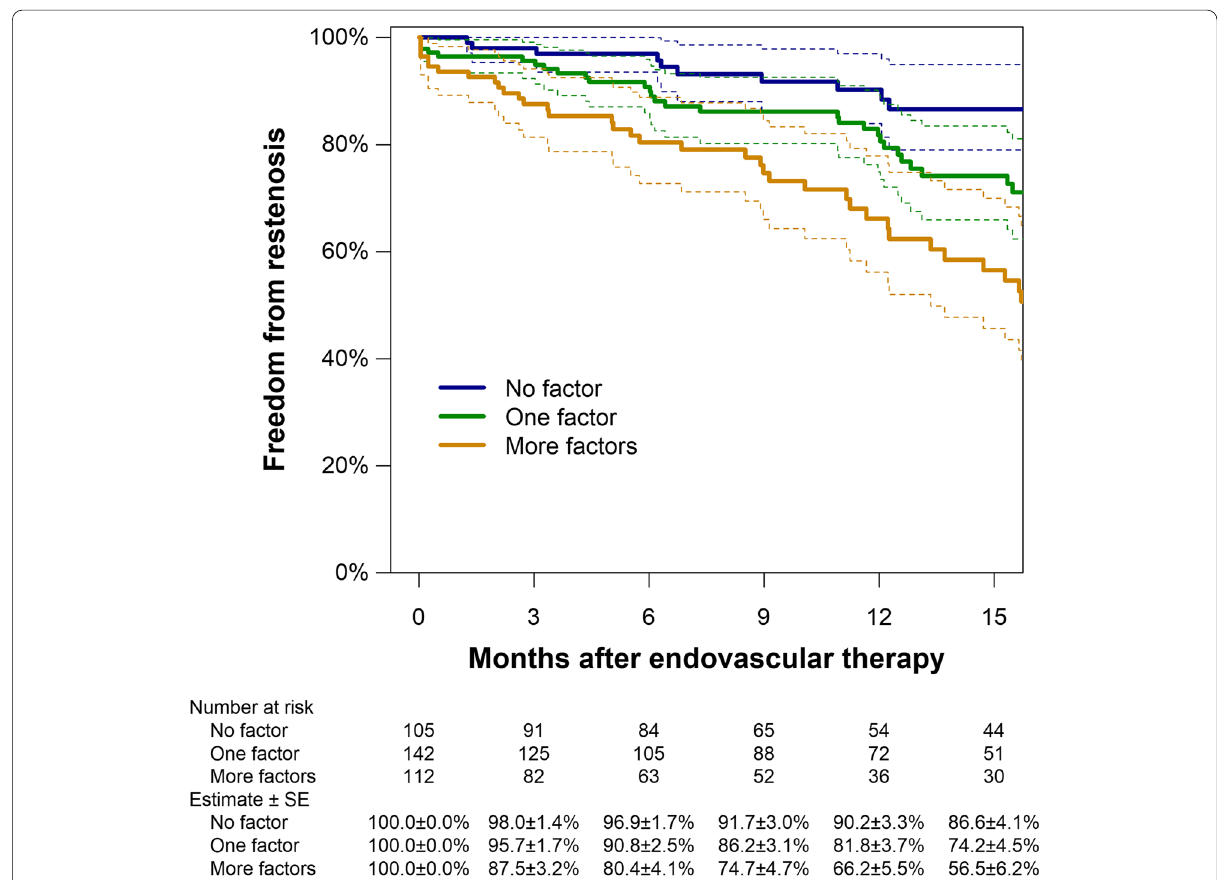
Fig. 2 Kaplan Meier estimates of primary patency based on the accumulation of restenosis risk factors. Dotted lines indicate 95% confidence intervals. SE, standard